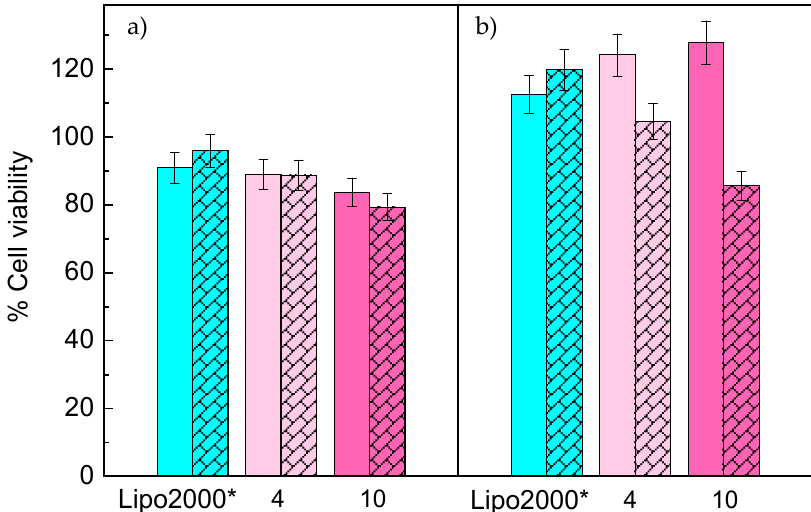
Figure 3. Percentage of cell viability of HeLa-GFP ( a ) and T731-GFP ( b ) cell lines in the presence of C 3 (C 16 His) 2 / MOG-siRNA lipoplexes (pink bars) at α = 0.2 and ρ e ff = 4 and 10. The % of cell viability was normalized to those obtained for untreated cells. Unstriped and striped bars correspond to 48 and 72 h of incubation, respectively. The blue bar corresponds to commercial control Lipo2000*-antiGFP-siRNA, used here as positive control. The experiments were performed with 10% ( v / v ) of HS, the data represent the mean of three wells, and errors are within ±5%.